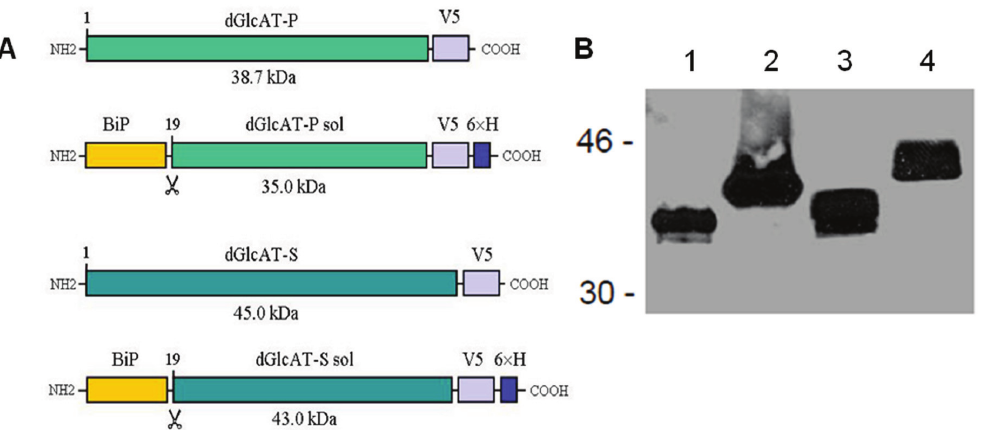
Figure 1. ( A ) Recombinant glucuronyltransferase fusion proteins expressed in Drosophila cells. Plasmids encoding intracellular (dGlcAT-P, dGlcAT-S) and secreted (dGlcAT-P sol, dGlcAT-S